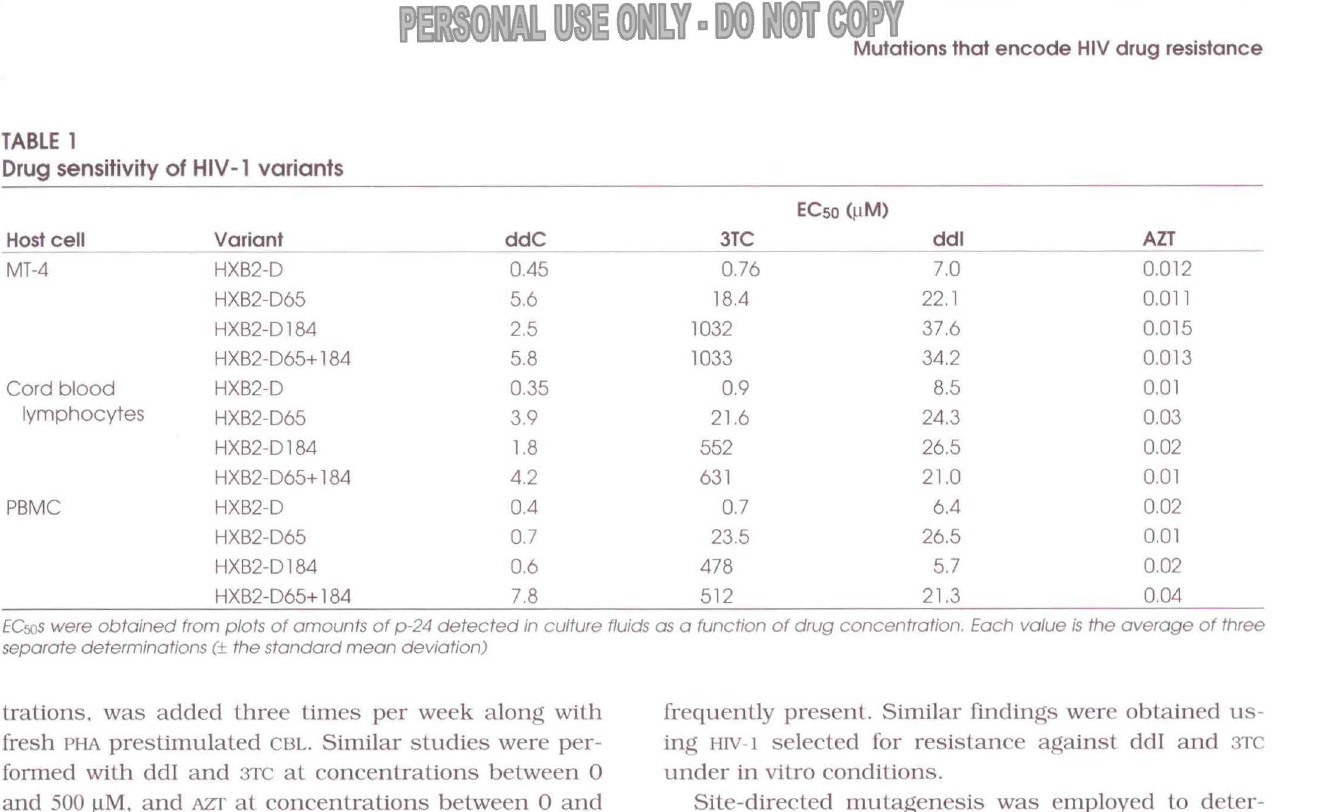
TABLE l Drug sensitivity of HIV- 1 variants Host cell MT-4